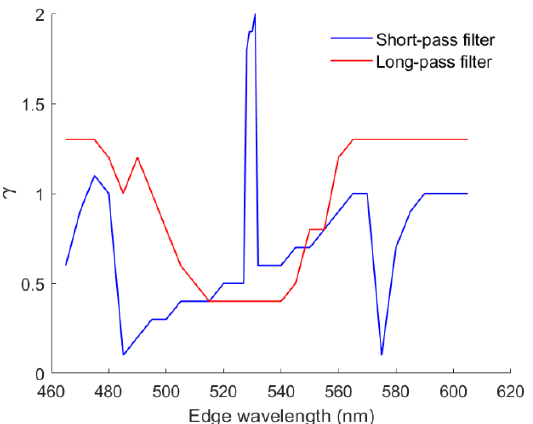
Figure 15. The optimized values of γ for the case of using the wPCA method in Figures 13 and 14. From Figure 13a,b, using the LUT method, the quadcolor camera optimized for the minimum mean Δ E 00 is the RGBS camera using the short-pass optical filter of λ S = 528 nm. For this optimized RGBS camera, the mean E Ref = 0.0115 and Δ E 00 = 0.1666, where the mean E Ref is larger than the RGBF camera but smaller than the D5100 camera; the mean Δ E 00 is much sm aller than the RGBF and D5100 cameras; the maximum Δ E 00 is only 1.0169. Using the wPCA method, the edge wavelength of the optimized RGBS is λ S = 529 nm and the optimized γ = 1.9. For this optimized RGBS camera, the mean E Ref = 0.0141 and Δ E 00 = 0.158, where the mean E Ref and Δ E 00 are larger and smaller, respectively, than the D5100 and RGBF cameras. From Figure 14a,b, using the LUT method, the quadcolor camera optimized for the minimum mean E Ref is the RGBL camera using the long-pass optical filter of λ L = 585 nm. The mean E Ref = 0.0083 and Δ E 00 = 0.3506 using the optimized RGBL camera with λ L = 585 nm are smaller than the mean E Ref = 0.0089 and Δ E 00 = 0.3992 using the RGBF camera, respectively. Using the wPCA method, the edge wavelength of the optimized RGBL is λ L = 587 nm and the optimized γ = 1.3. The mean E Ref = 0.0087 and Δ E 00 = 0.3862 using the optimized RGBL camera are smaller than the mean E Ref = 0.0095 and Δ E 00 = 0.4257 using the RGBF camera, respectively. For the cases of using the LUT method, the spectral transmittance of the optimized long-pass and short-pass optical filters and their corresponding fourth channel spectral sensitivities are shown in Figure 3b. The histograms of assessment metrics for using the optimized RGBS and RGBL cameras are shown in Figure 11a – d for the case of using the LUT method. Figure 12a – d are the same as Figure 11a – d, respectively, except for the case of using the wPCA method. From Figures 11a – d and 12a – d, it can be seen that the histo- gram characteristics for the RGBC and RGBL cameras are similar when using the LUT method or the wPCA method. The histogram characteristics for the RGBS camera are quite different from those for the RGBC and RGBL cameras when using the LUT method or the wPCA method. For the case of using the RGBS camera and the LUT method, there are 28, 52 and 2 test samples in the “ E Ref > 0.05”, “GFC < 0.99” and “SCI > 20” bins, respec- tively, while there is only 1 test sample in the “Δ E 00 = 1.1” bin and no test sample in the larger Δ E 00 bins. For this case, the color difference of all test samples is low despite the large spectral error. For the case of using the RGBS camera and the wPCA method, there are 52, 82, 4 and 14 test samples in the “ E Ref > 0.05”, “GFC < 0.99”, “Δ E 00 > 2.0” and “SCI > 20” bins, respectively. For this case, most of the test samples have a low color difference, but there are few test samples with a large color difference. Therefore, if the RGBS camera is used as an imaging colorimeter, it is more reliable to reconstruct spectra using the LUT method. Table 5 shows the assessment metric statistics for the test samples of the optimized RGBS and RGBL cameras using the LUT and wPCA methods. For the case of using the